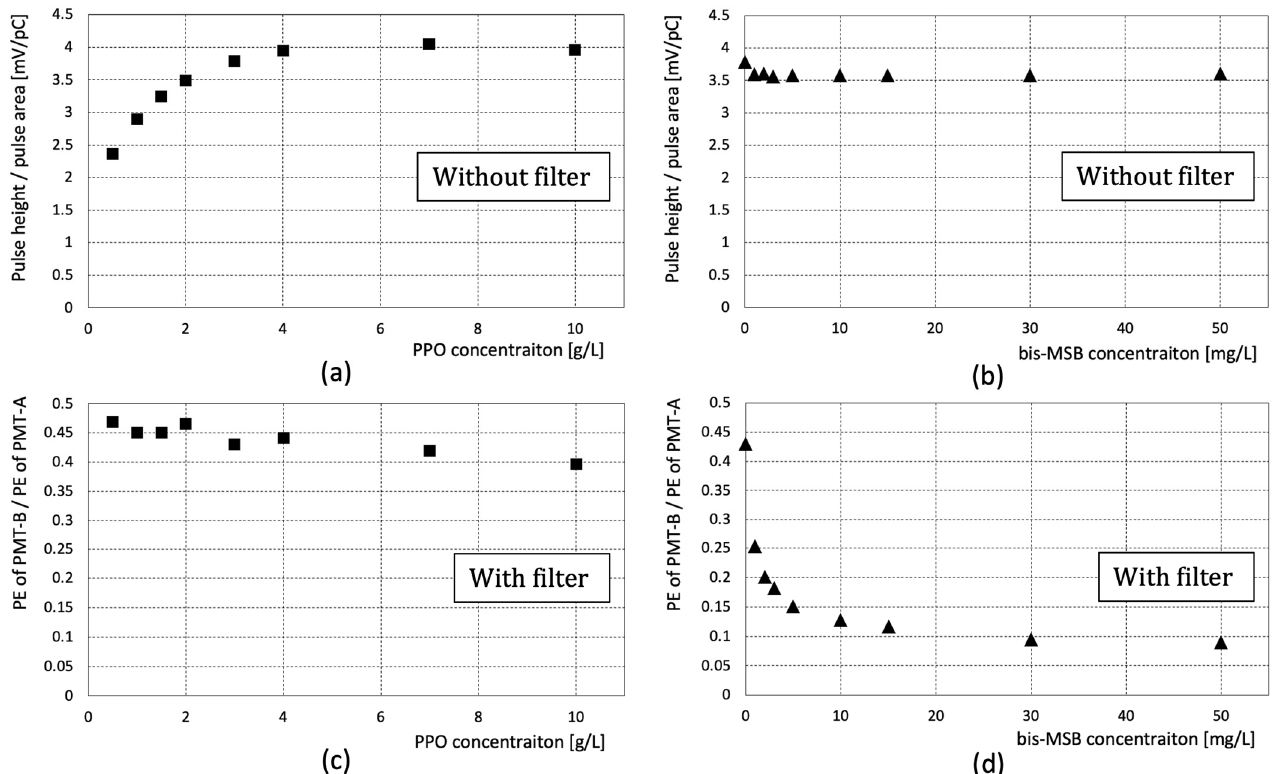
Figure 8. ( a ) Area normalized pulse height with different PPO concentrations; ( b ) Area normalized pulse height with different bis-MSB concentration; The pulse height of Figure ( a , b ) were obtained without the short-pass filter; ( c ) The ratio of PE passing through the short-pass filter with different PPO concentrations; ( d ) The ratio of PE passing through the short-pass filter with different bis-MSB concentration. In Figure ( b , d ), the PPO concentration is kept constant at 3 g/L. Note that the amount of bis-MSB is less than that of PPO by a factor of ~1000.